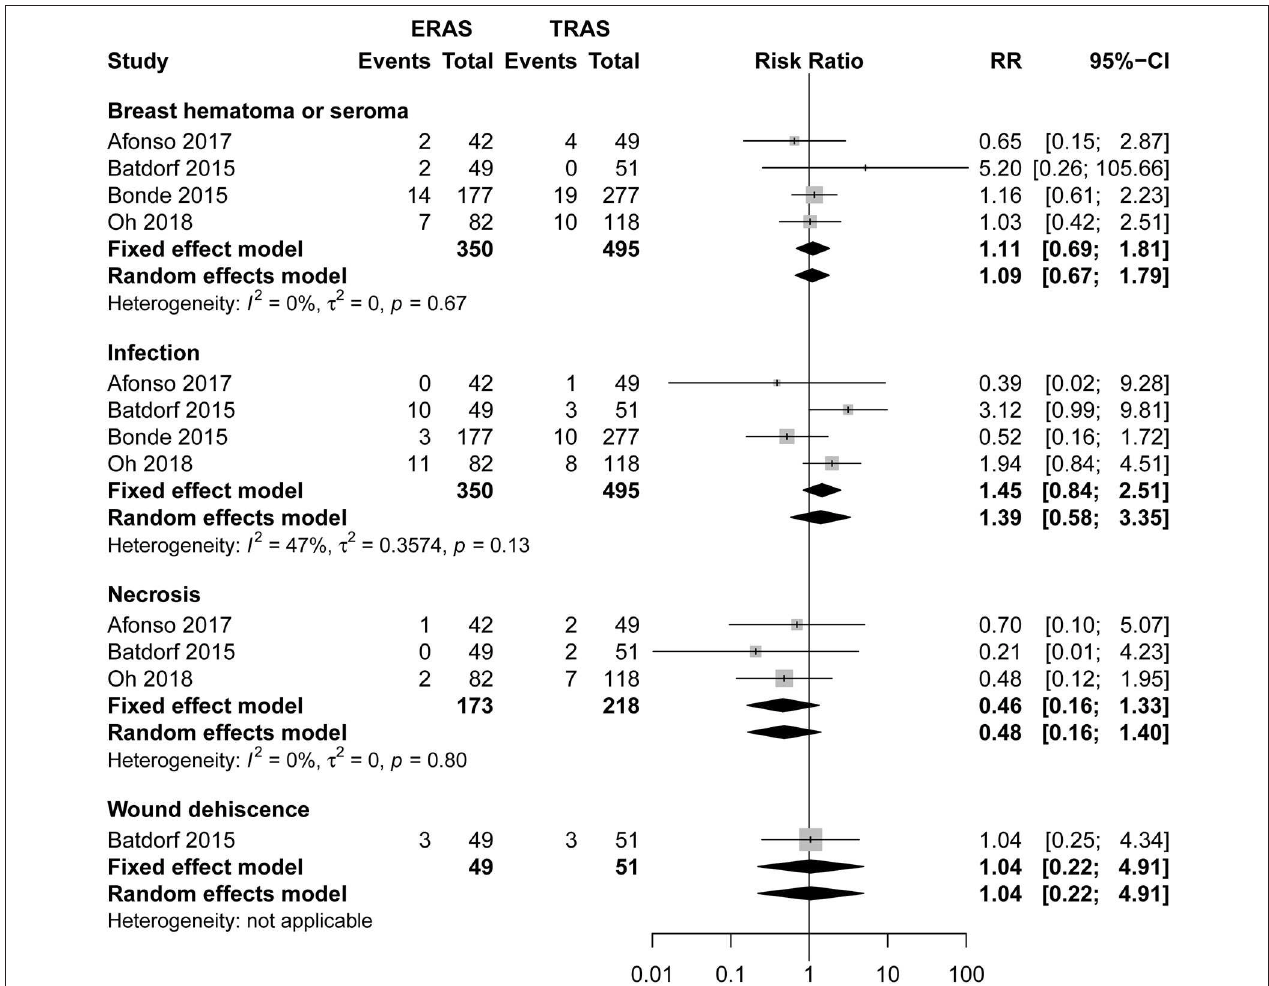
FIGURE 3 | Pooled estimate of the effect of ERAS programs on incidence of breast-related complications within 30 days after autologous breast reconstruction surgery compared to conventional perioperative care